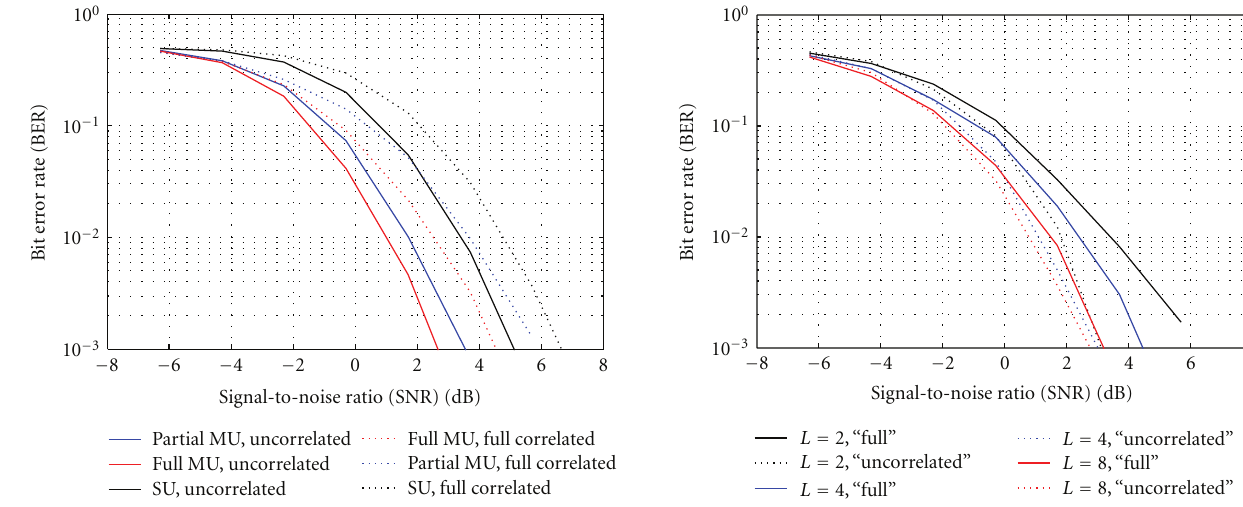
Figure 3: BER performance for interference-aware allocation, for L = 2 with di ff erent types of feedback. Figure 4: BER performance between di